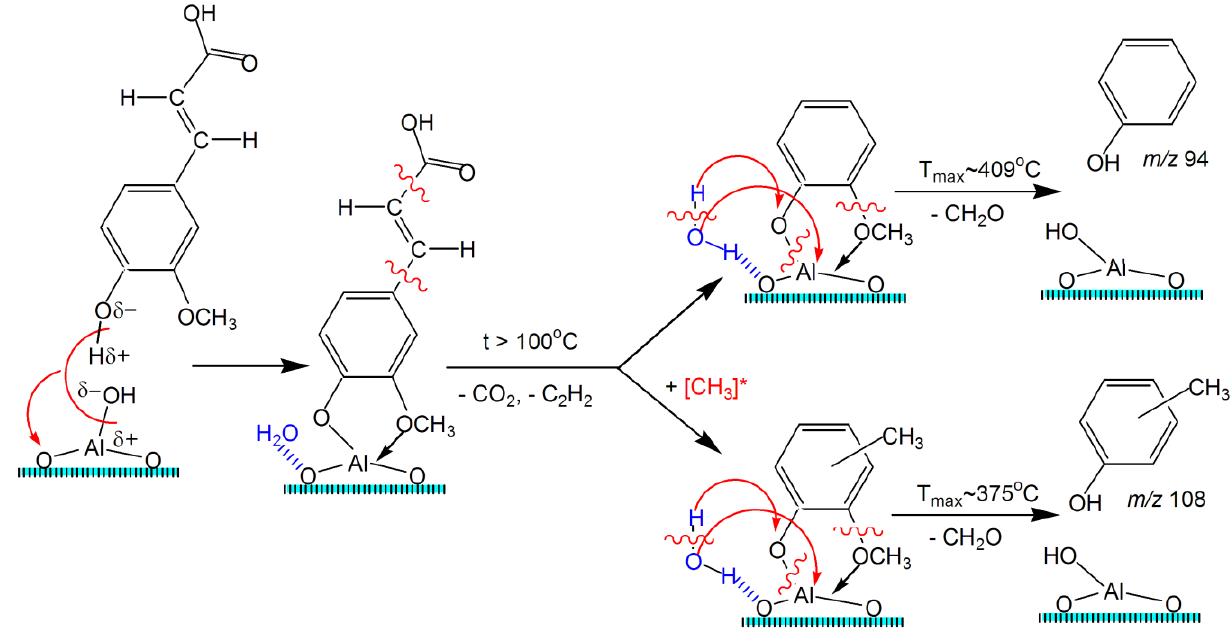
Figure 9. TPD-curves for the molecular and/or fragment ions of aromatics with m/z 78 (benzene), 91 (tropylium ion, C 7 H 7+ ), 115 (indene), 128 (naphtalene), and 141 (methylnaphtalene).